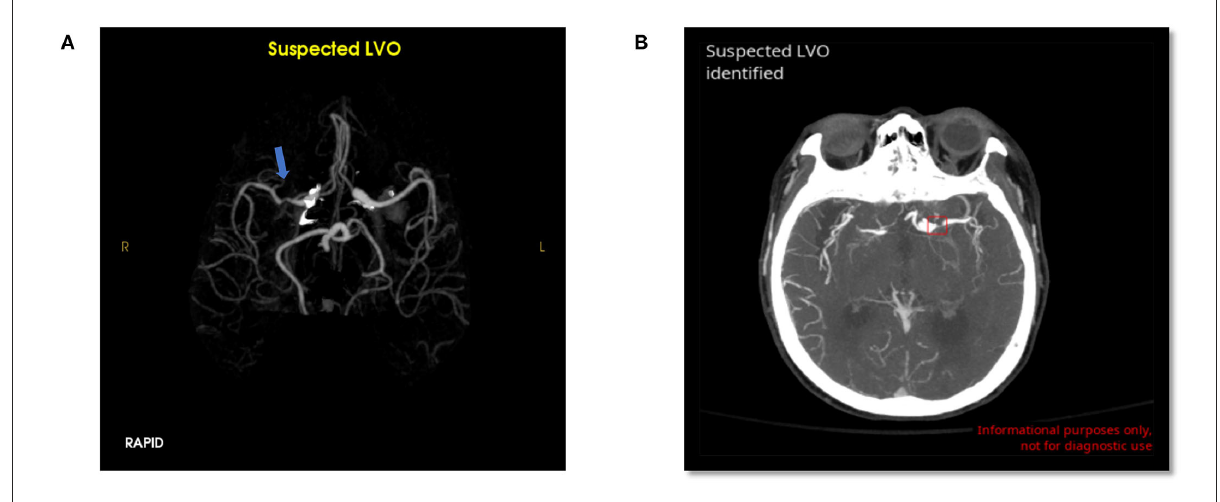
FIGURE3 False positive LVO from RAPID LVO ( A , blue arrow, right M1 MCA) and CINA LVO ( B , red box, left M1 MCA). These type 1 errors were likely due to